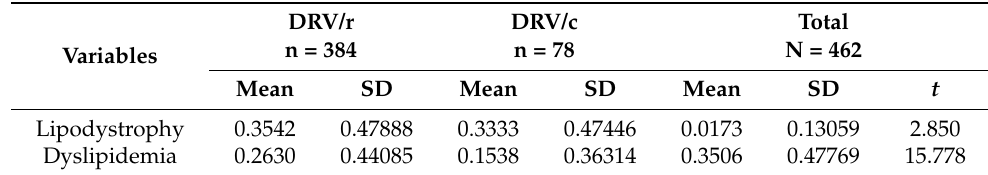
Table 5. Descriptive statistics: prevalence of lipodystrophy and dyslipidemia ( p < 0.01).